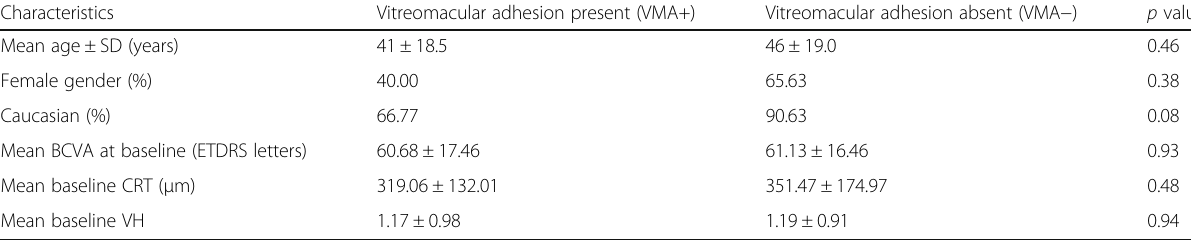
Table 1 Baseline characteristics of the study population